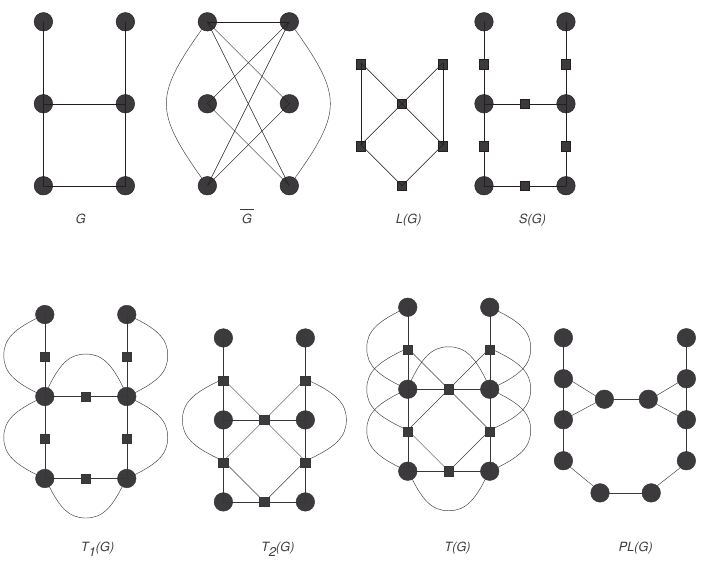
Figure 1. Different graphs derived from G